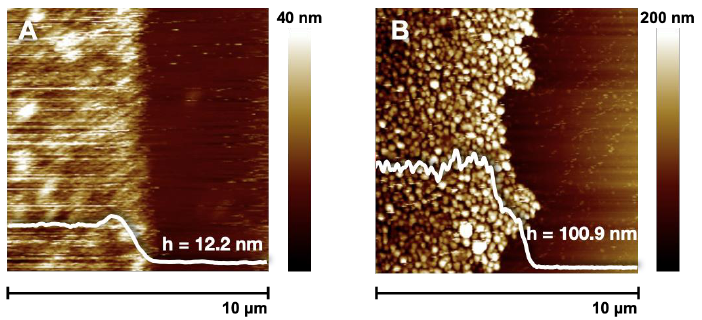
Figure 1. AFM images of poly( St-D - alt - Ma-A ) brushes obtained via RAFT technique: ( A ) after 2 h; ( B ) after 24 h of polymerization. Table 3. Thickness of poly( St-D - alt - Ma-A ) brushes obtained during various times of RAFT polymerization.